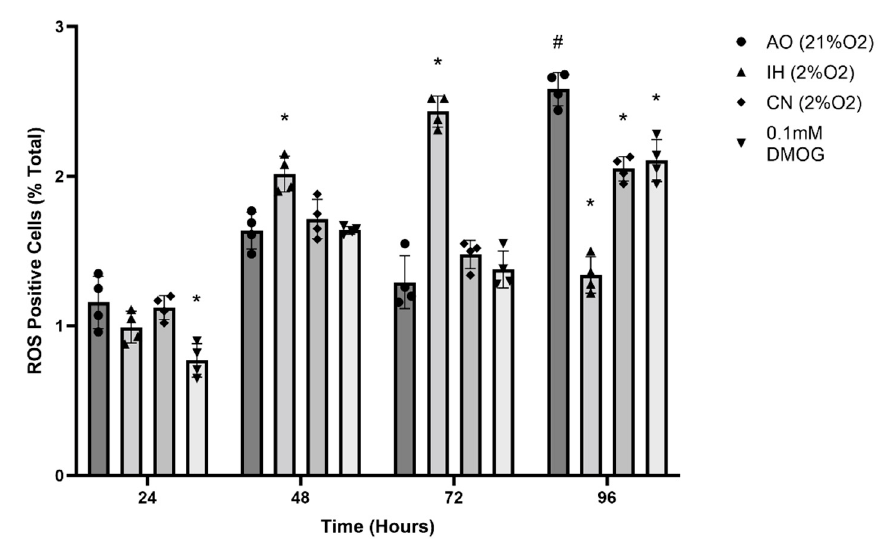
Figure 4. Reactive oxygen species (ROS) formation at different oxygen levels and with DMOG. His- togram of normalised fluorescence intensity of PC12 after stain with ROS-ID Hypoxia/Oxidative stress detection reagent. The exposure of PC12 cells to IH significantly increased the ROS level com- pared to cells in AO after 48 and 72 h. DMOG significantly reduced ROS formation at 24 h. Further- more, cells in AO for 96 h significantly increased ROS formation compared to cells in AO after 24 h, while 2% O 2 (IH and CN) and DMOG significantly reduced the increase in ROS formation levels after 96 h incubation. Data are presented as mean of normalised values ± S.E.M, n = 4. Statistical significance of the assay was evaluated using one-way ANOVA with Tukey post hoc corrections. * indicates significant difference in comparison to control at each time point ( p < 0.05). # indicates significant change in comparison to corresponding values recorded on day 1 ( p < 0.05).